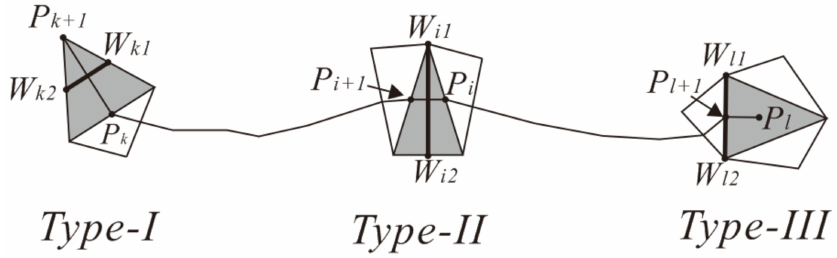
Figure 2. Triangular element